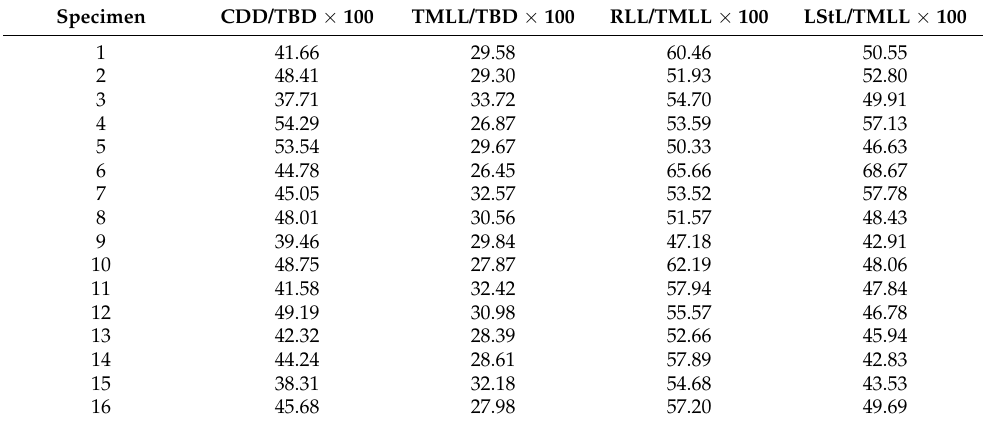
Table 1. Proportions of body sizes in ephyrae of Stomolophus sp. 2. CDD, central disk diameter; TBD,